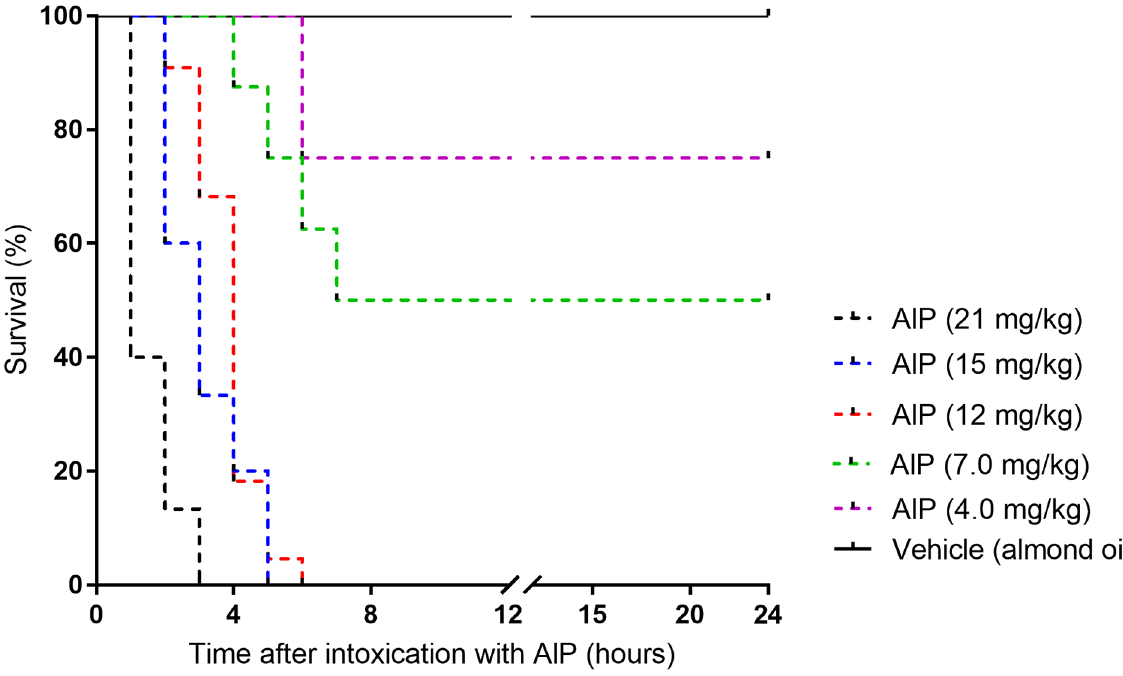
Fig 1. Kaplan-Meier graph showing the survival rate of rats intoxicated with different doses of oral aluminum phosphide (AlP) within 24 hours.